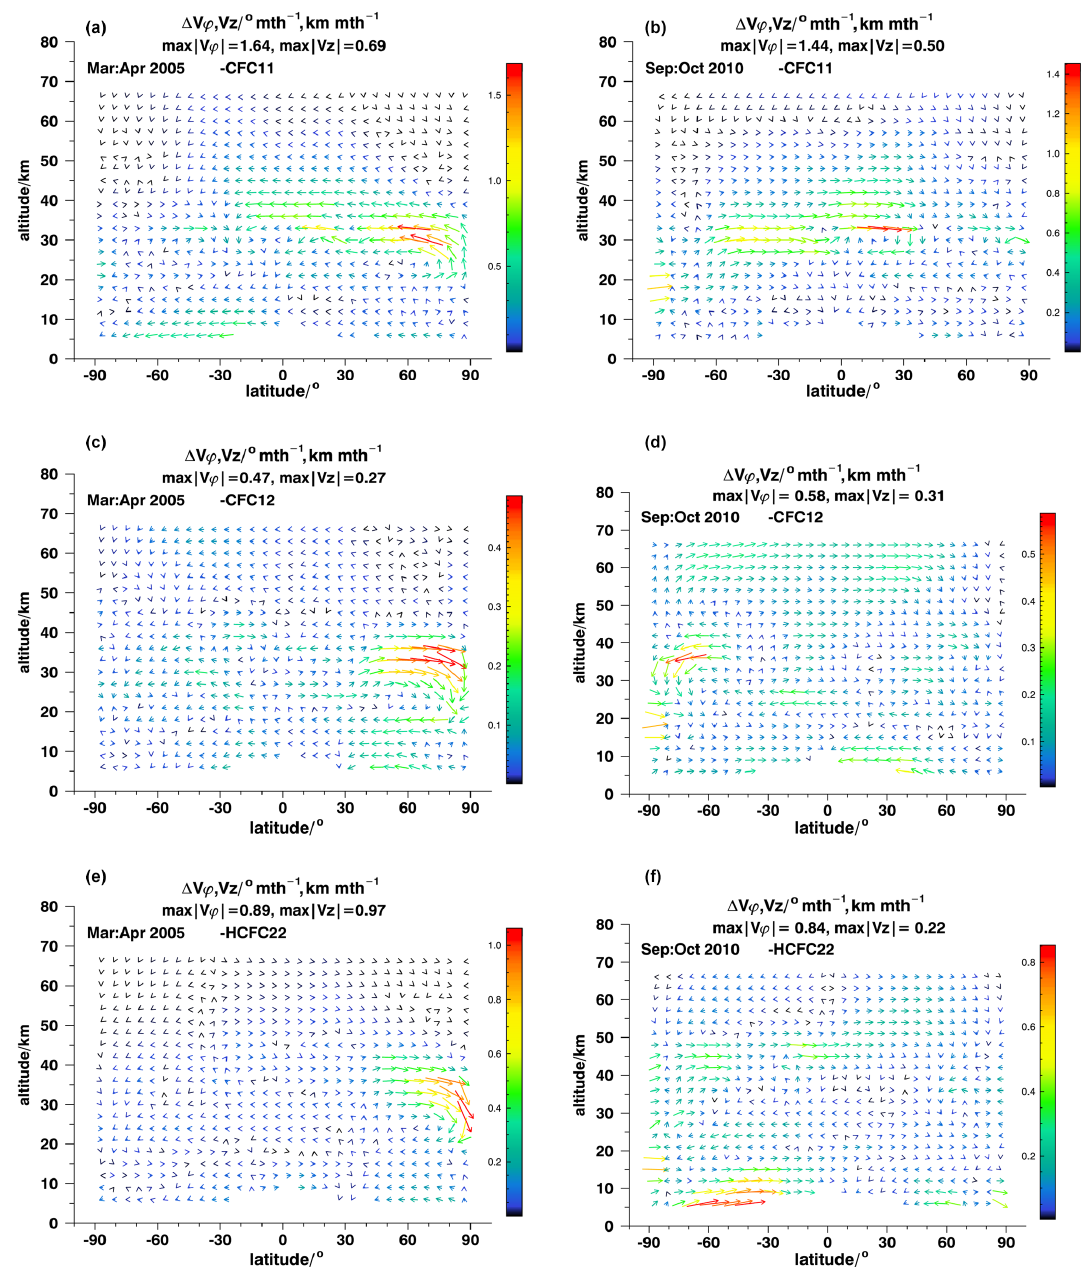
Figure 8. Differences between ANCISTRUS runs with one species omitted and all nine species included for March–April 2005 (a, c, e) and September–October 2010 (b, d, f) . The missing species are CFC-11 (a, b) , CFC-12 (c, d) , and HCFC-22 (e, f)